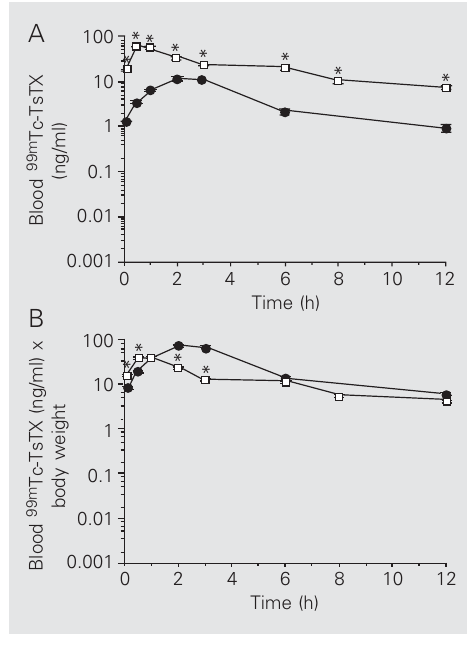
Figure 1. Blood concentration- time profile of adult (circles) and young (squares) male rats after subcutaneous injection of 6 µg 99m Tc-TsTX. Data are reported as means ± SEM (N = 5-8) with- out correction for body weight (A) and corrected for body weight (B). *P < 0.05 compared to adult rats (Student t -test).